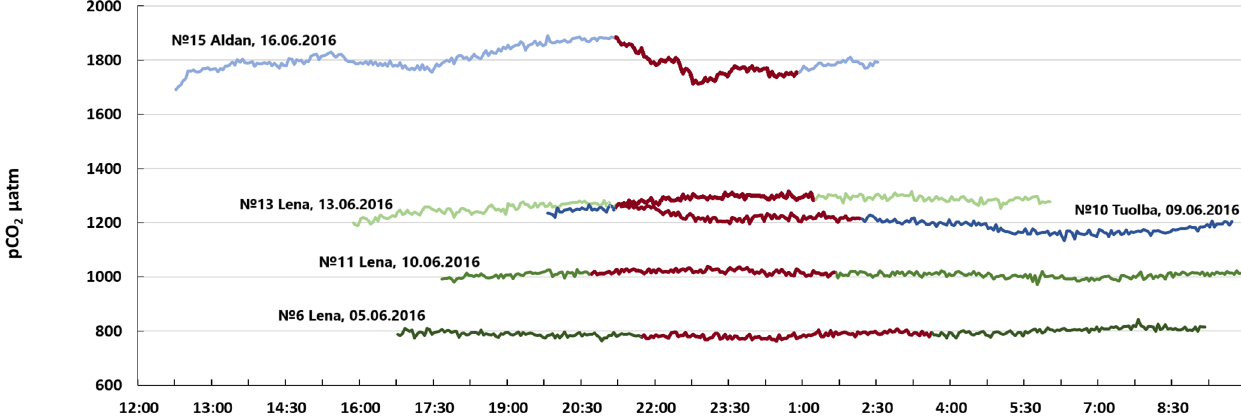
Figure 4. Continuous p CO 2 concentration in the Lena River and two tributaries from late afternoon to morning the next day. The red part of the line represents nighttime. Variations in water temperature did not exceed 2 ◦ C.